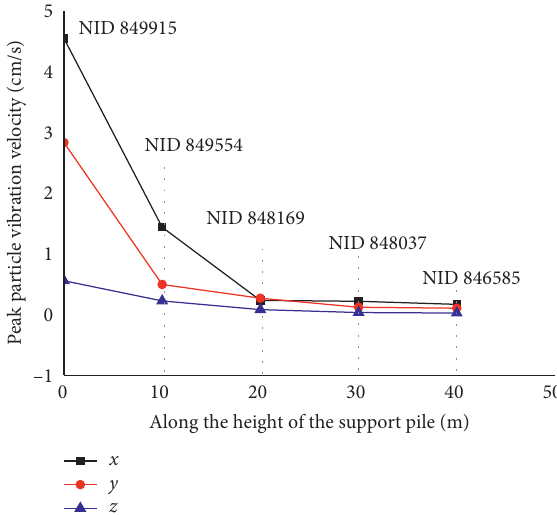
Figure 12: The response trend of PPV in three directions with increasing supporting pile